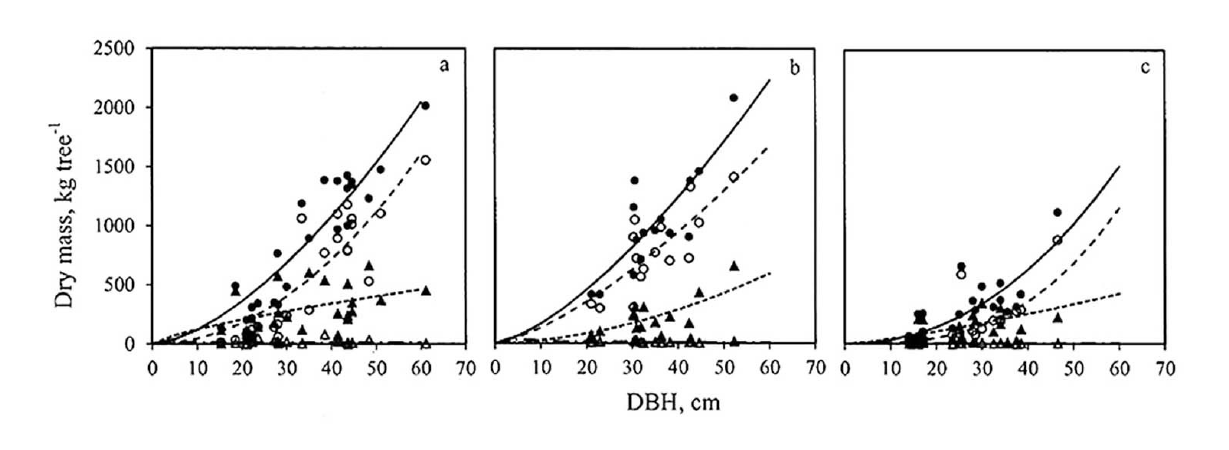
Figure 3. Dry mass per tree (kg tree -1 ) in relation to DBH (mm), of total ( ), stem ( ) branches ( ) and leaves ( ) for samples of Chanfuta ( a ), Jambire ( b ), and Umbila ( c